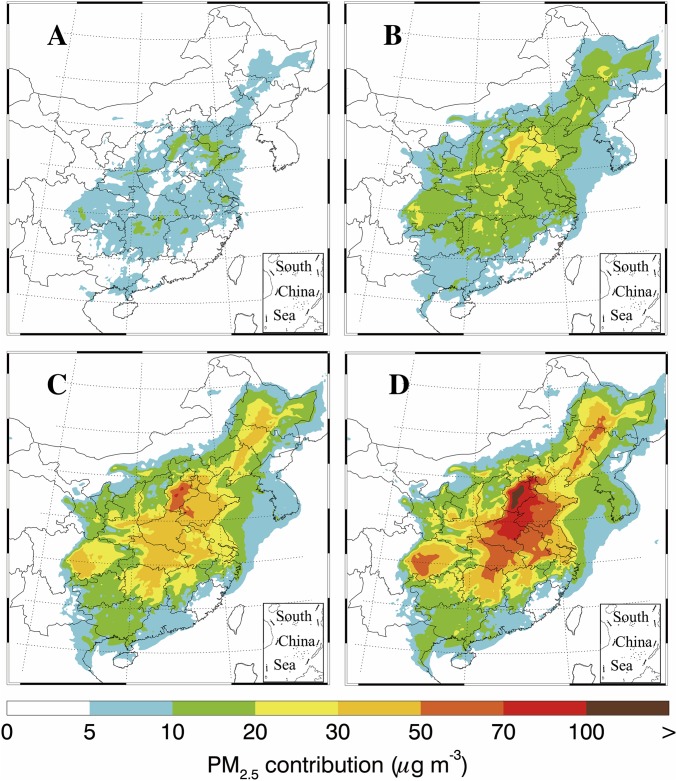
Contribution of agricultural NH3 associated reactions to PM2.5 mass, simulated by the WRF-Chem model in four different scenarios (A–D, representing 25, 50, 75, and 100% of the current NH3 level, respectively).